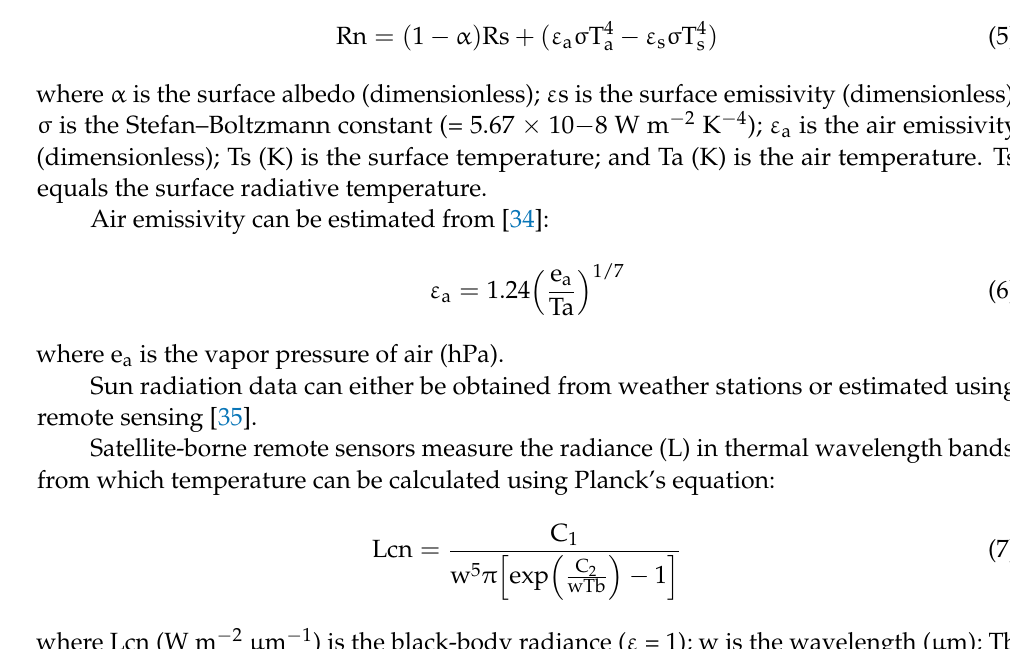
where PM is the average measurements over the sun-lit or shaded conditions and As is the area of sun-lit or shaded conditions in the footprint, as indicated by subindices vi =